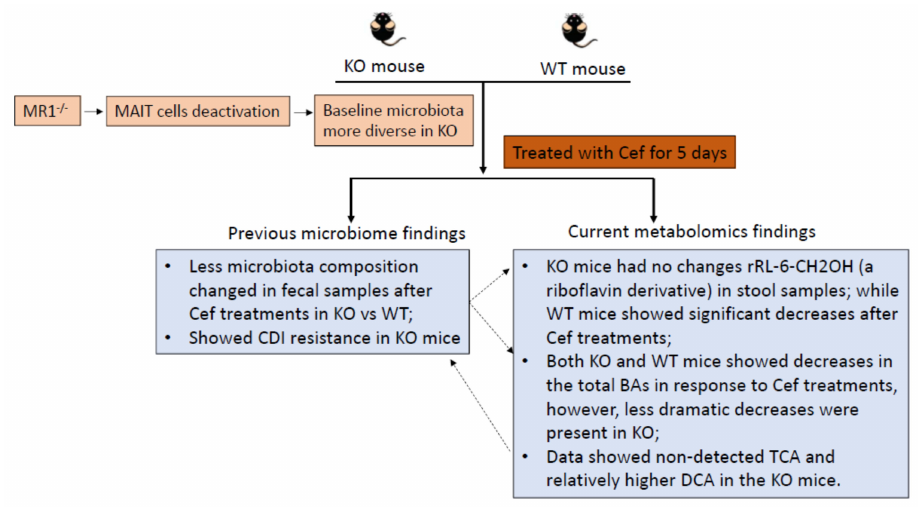
Figure 5. Schematic plot of the interconnections of previous microbiome studies and the current metabolomics study. KO mice with a di ff erent microbial composition both before and after Cef treatment might cause the distinct BA profile changes vs. WT mice. In return, the levels of TCA and DCA might influence microbial composition as well. CDI = Clostridioides di ffi cile